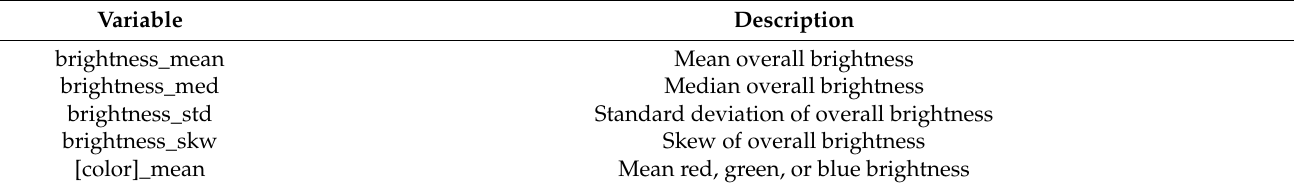
Table 2. Structural features extracted from UAV SfM. “[color]” notation indicates that each variable was constructed from each color (red, green, and